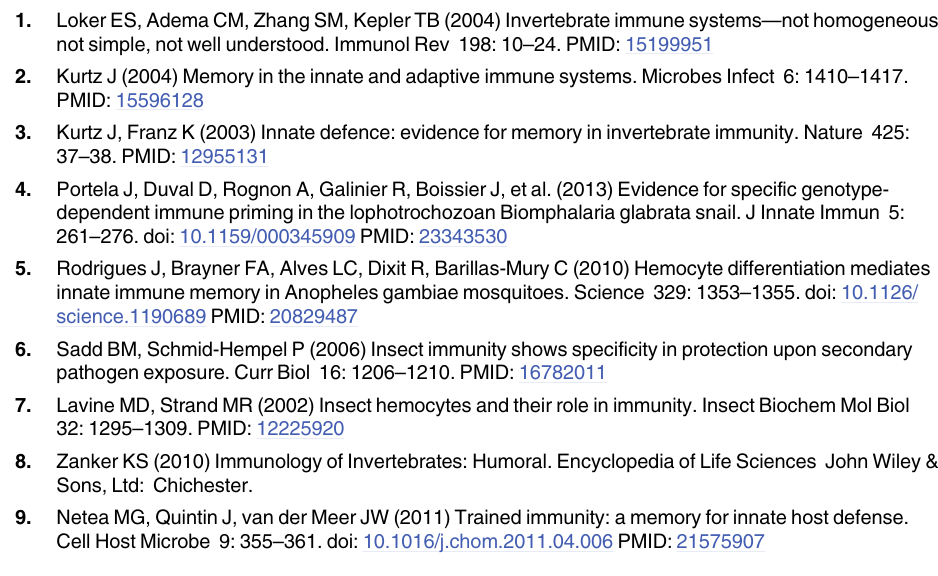
S2 Table. All cluster identified in Fig 5. Ratio of expression and mapping annotation were indicated for all the sequences identified as differentially regulated in the plasma comparative proteomic approach. S3 Table. Primers used for Q-RT-PCR. Identification numbers (iD), Blast2GO annotation and sequences of forward and reverse primers were indicated for 36 randomly selected tran- scripts of Naive1/Naive2 RNAseq biological samples. These sequences were used to analyse the correlation between the RNAseq reads per kilobase per million (log2 RPKM) values and the corresponding Q-RT-PCR cycle threshold (Ct) see S1